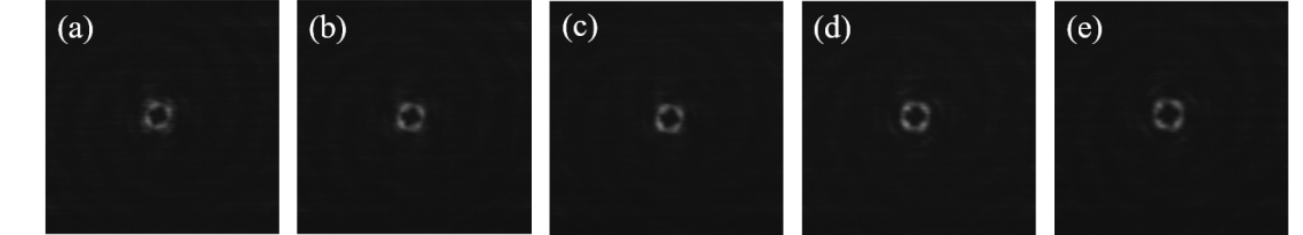
Figure 14. Captured images of the CSZPG at the positions of ( a ) z = 220 mm, ( b ) z = 230 mm, ( c ) z = 250 mm, ( d ) z = 270 mm and (e) z = 290 mm, respectively.